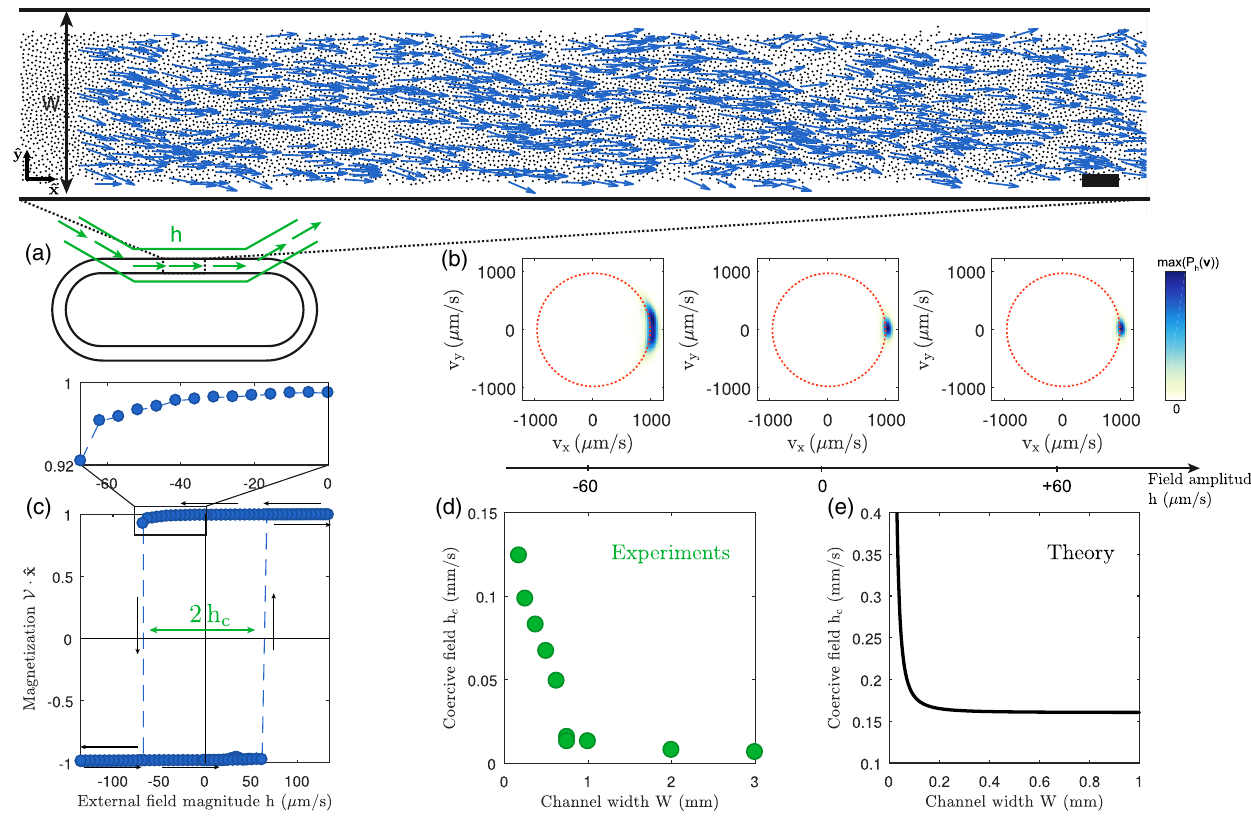
FIG. 2. Nonlinear response of polar liquids to longitudinal external fields. (a) Bottom: Sketch of the microfluidic geometry. The rollers are confined in a photolithographied racetrack (black). A constant hexadecane flow is applied to the rollers by means of an additional microfluidic channel (green). Top: Close-up on the homogeneous polar liquid flowing in a racetrack of width W ¼ 0 . 5 mm when h ¼ 0 . In this experiment, the polar liquid spontaneously flows along the clockwise direction as indicated by the instantaneous particle velocities (blue arrows). The velocity of one roller out of ten is plotted. The scale bar represents 100 μ m. (b) Probability density function of the roller velocities in the polar-liquid state. At h ¼ 0 , the distribution is biased, revealing the spontaneous symmetry breaking of the roller orientation. At h ¼ þ 60 μ m = s, transverse velocity fluctuations are reduced. At h ¼ − 60 μ m = s, the polar liquid cruises against the external field and velocity fluctuations are enhanced. The speed of the rollers v 0 (red dotted circles) is left unchanged by the external field. (c) Magnetization curve V · ˆ x ð h Þ of the polar liquid. Upon cycling the external field h (dark arrows), the active ferromagnet displays a hysteretic behavior. The coercive field h is defined as the width of the hysteresis loop. Top: Close-up showing the minute c decrease of the magnetization prior to reversal. (d) The coercive field h decreases with the channel width W (green dots). (e) Theoretical ffiffiffiffiffiffiffiffi p c ð W Þ ¼ ð 2 = 243 Þ α v ð 1 þ 2 D q 2 = α Þ 3 = 2 . As a technical remark, we note that the limit W → ∞ is not relevant. Our two- prediction h 0 c T mode model is intrinsically based on the scale separation between the variations of the longitudinal and transverse components of v : v x varies over the scale of the channel length, while v y varies over the channel width. Unconfined polar liquids cannot resist external